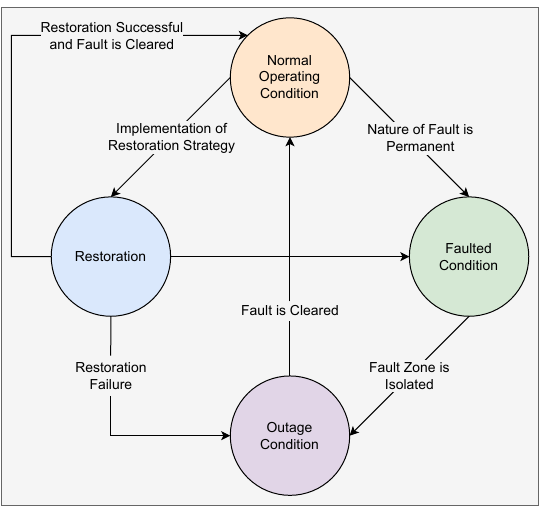
Figure 5. System operating conditions during restoration